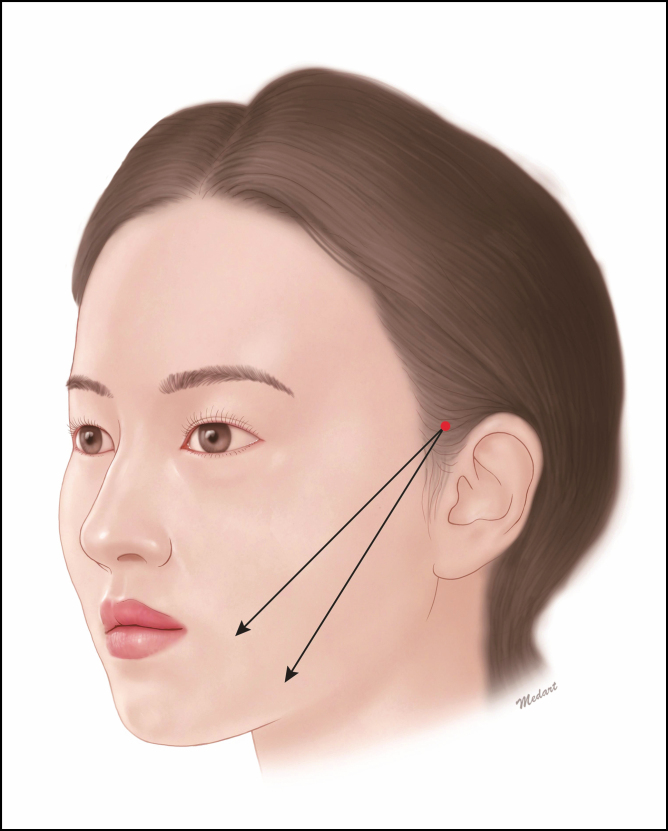
Location of the entry site below the ear or on the tragus. To determine the vector from the entry point to the exit one, the former is located on the zygomatic arch and the latter is determined in the jowl.